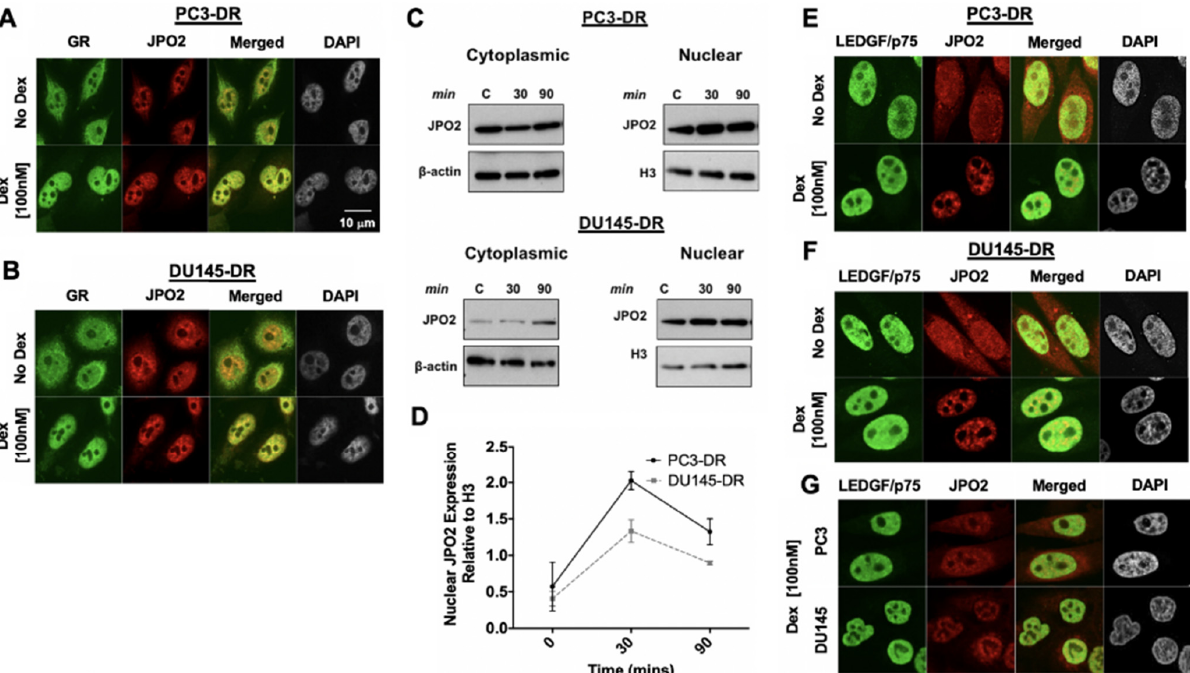
Figure 4. JPO2 co-localizes with LEDGF/p75 upon dexamethasone-induced nuclear translocation. ( A , B ) Dexamethasone induced JPO2 nuclear translocation in the DTX-resistant PCa cells PC3-DR and DU145-DR. Cells growing in charcoal-